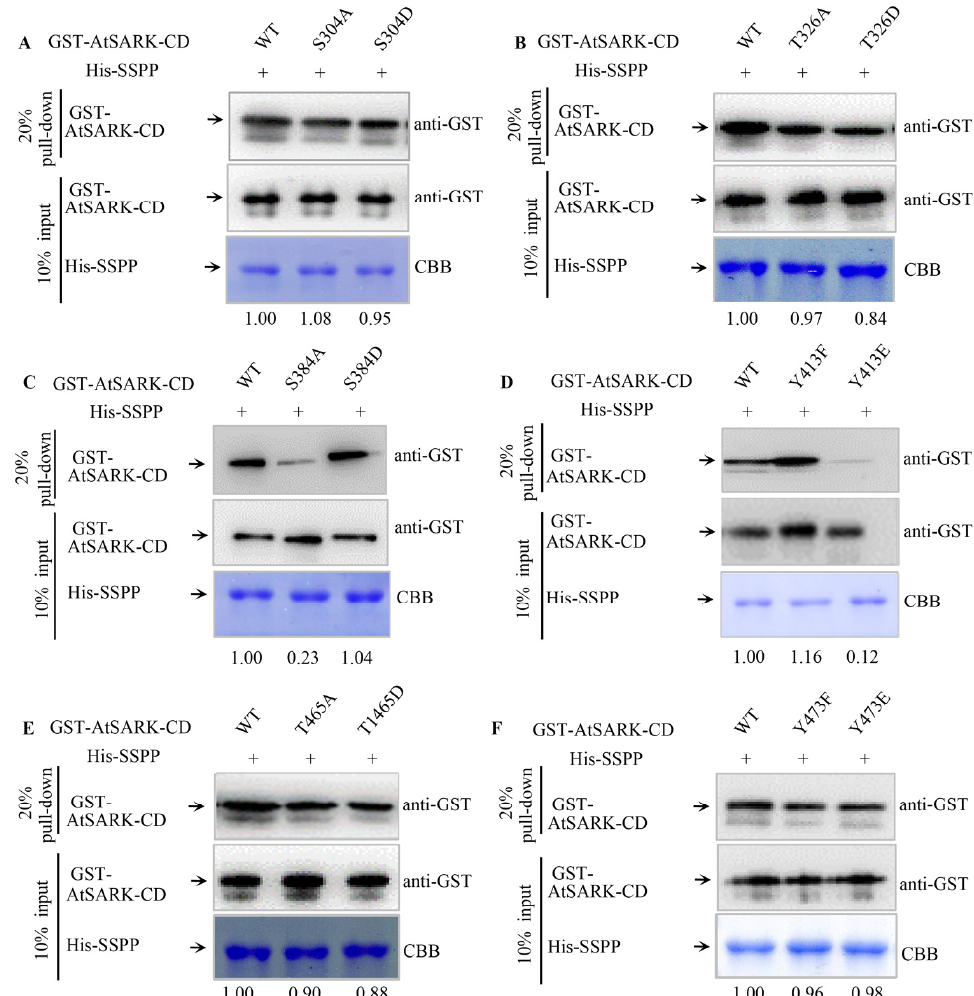
Figure 4. Impacts of phosphorylation status of six key phosphorylation residues of AtSARK on the interaction with senescence-suppressed protein phosphatase SSPP. ( A – F ): In vitro pull-down assays showing the interactions between SSPP and the phosphorylation- or dephosphorylation-mimicking mutants of AtSARK at S304, T326, S384, Y413, T465, and Y473 residues, respectively. GST-tagged wild-type AtSARK-CD (WT) or its mutated alternative were incubated with His-SSPP-bound Ni-NTA beads. Detailed protocol of the in vitro pull-down assay is described in Section 4. Input wild-type or mutated AtSARK proteins were detected with anti-GST antibody while input His-SSPP proteins were examined with Coomassie Brilliant Blue (CBB) staining. Solid arrows indicate the migration of each protein. Numbers below the blots indicate the relative intensity ratio between AtSARK pull-down band to input His-SSPP band in each lane with those of the wild-type AtSARK-CD normalized to 1. Data presented are the typical results of three independent biological